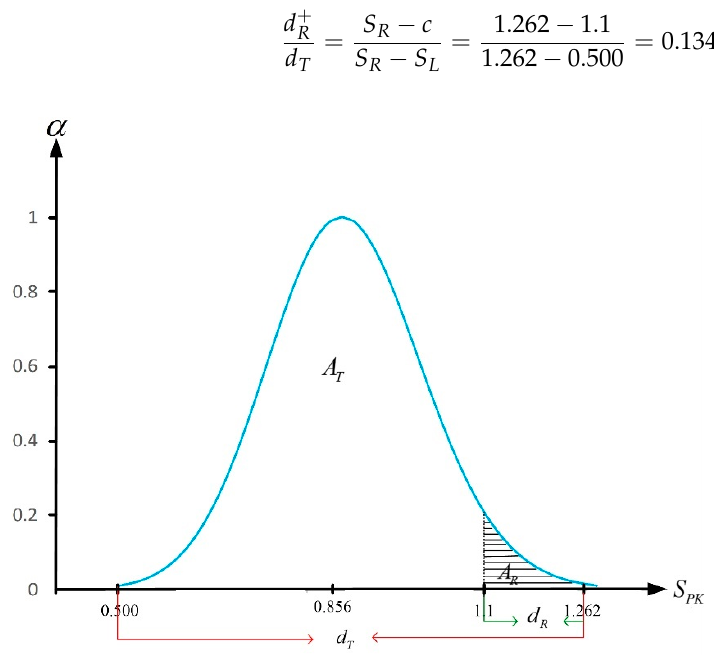
Figure 4. Membership functions of η ( x ) with x =